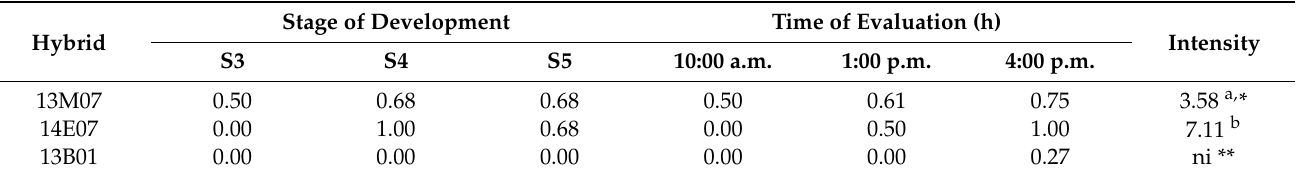
Table 1. Summary of the averages obtained for the sensorial analysis of floral scent perceived in alstroemeria (yes = 1 and no = 0) at different stages of development and different times of evaluation. Values for the intensity of the floral scent (extremely high = 9 and extremely low = 1) are shown for the scented hybrids. Stage of Development Time of Evaluation (h) Hybrid Intensity S3 S4 S5 10:00 a.m. 1:00 p.m. 4:00 p.m. 13M07 0.50 0.68 0.68 0.50 0.61 0.75 3.58 a, * 14E07 0.00 1.00 0.68 0.00 0.50 1.00 7.11 b 13B01 0.00 0.00 0.00 0.00 0.00 0.27 ni **